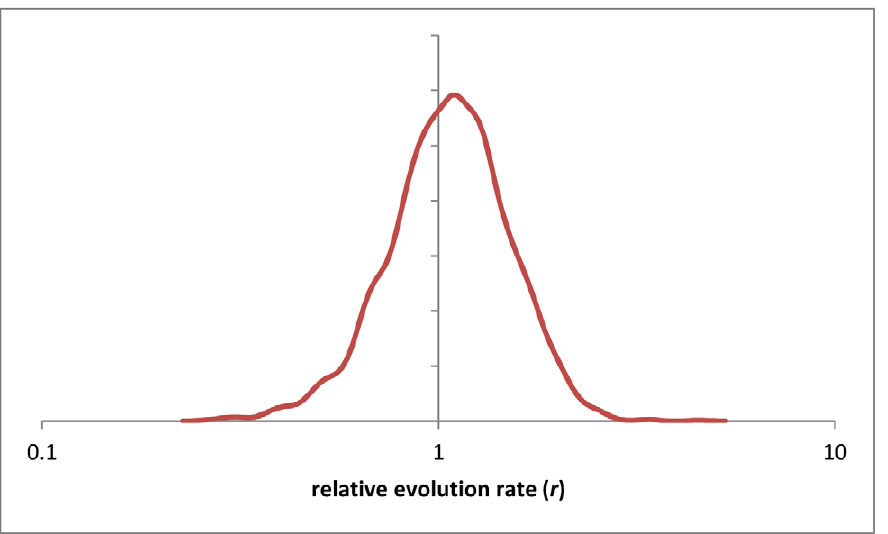
Figure 5. The distribution of the relative evolution rates ( r k values) for 2294 gene families obtained by fitting gene trees to the UPM (unconstrained) supertree. The curve was smoothed using the Gaussian-kernel method.